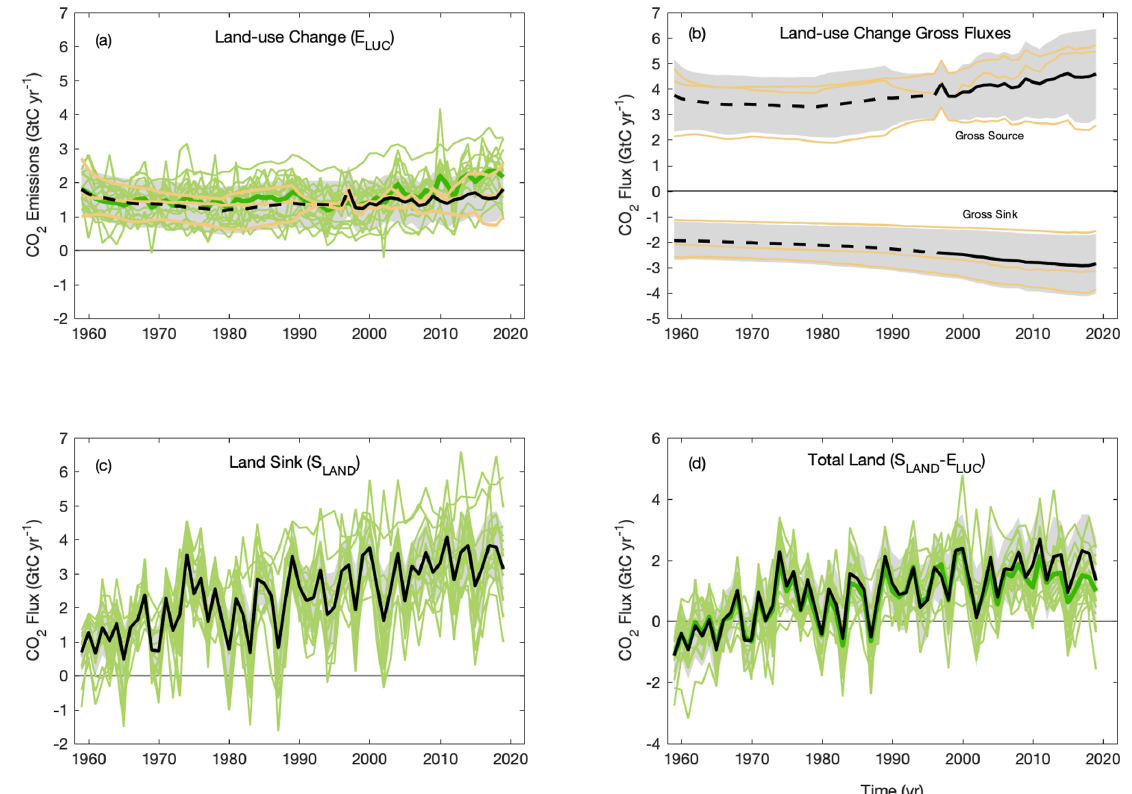
Figure 6. CO 2 exchanges between the atmosphere and the terrestrial biosphere as used in the global carbon budget (black with ± 1 σ uncertainty in grey shading), for (a) CO 2 emissions from land-use change ( E LUC ). Estimates from the three bookkeeping models (brown lines) and the DGVM models (green) are shown individually, as is the multi-model mean of DGVM models (dark green). The dashed line identifies the pre-satellite period before the inclusion of peatland burning. (b) CO 2 gross sinks (from regrowth after agricultural abandonment and wood harvesting) and gross sources (decaying material left dead on site and from products after clearing of natural vegetation for agricultural purposes, wood harvesting, and, for BLUE, degradation from primary to secondary land through usage of natural vegetation as rangeland, and emissions from peat drainage and peat burning). The sum of the gross sinks and sources is E LUC . Estimates from the three bookkeeping models (brown lines) are shown individually. (c) Land CO 2 sink ( S LAND ) with individual DGVMs (green). (d) Total land CO 2 fluxes ( c minus a ) with individual DGVMs (green) and their multi-model mean (dark